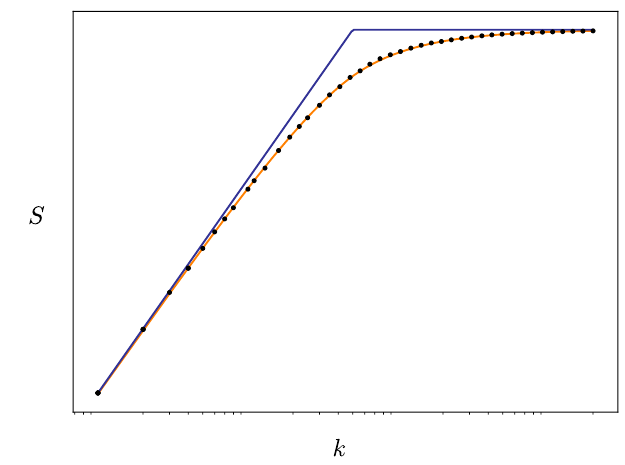
50 , showing (3.15) (black dots) and the planar (cid:16)